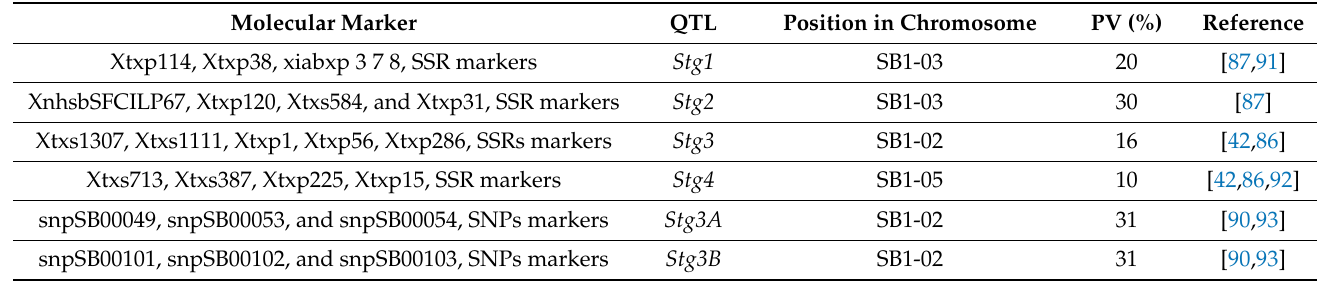
Figure 2. Linkage group of Stg1 and Stg2 in SB1-03 [86]. Table 1. Molecular Markers and Stay-green QTLs for Drought Tolerance in